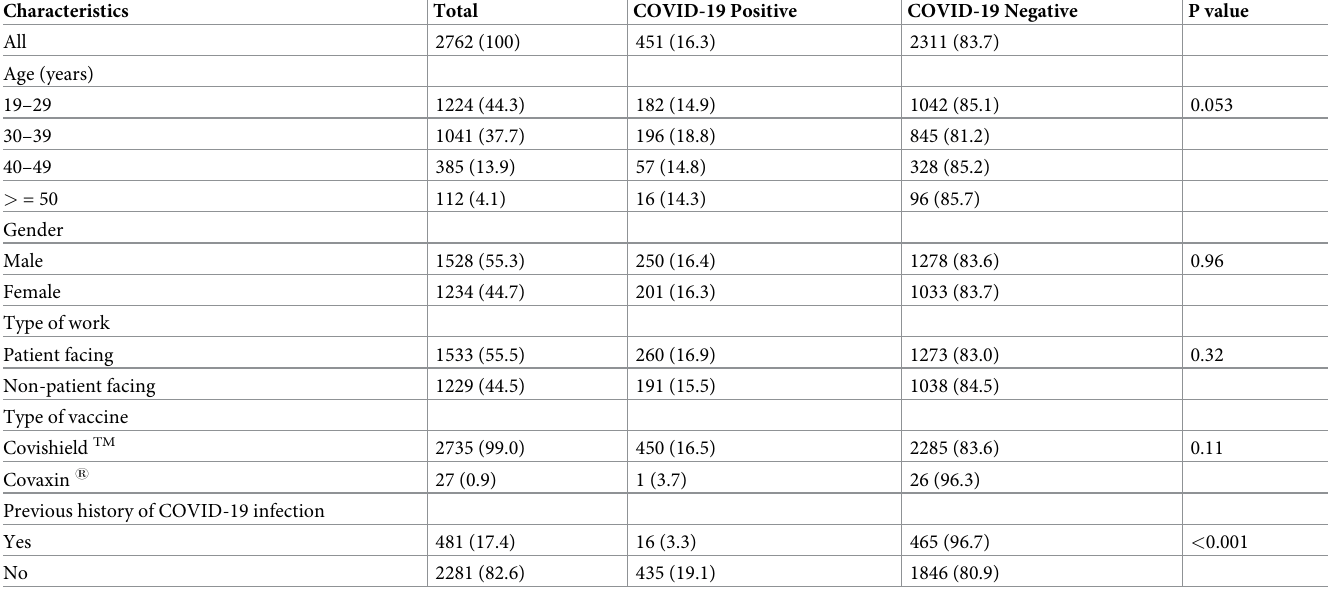
Table 1. Table showing the proportion of COVID-19 infections in a cohort of 2762 health care personnel in a tertiary care centre, Mumbai, India.